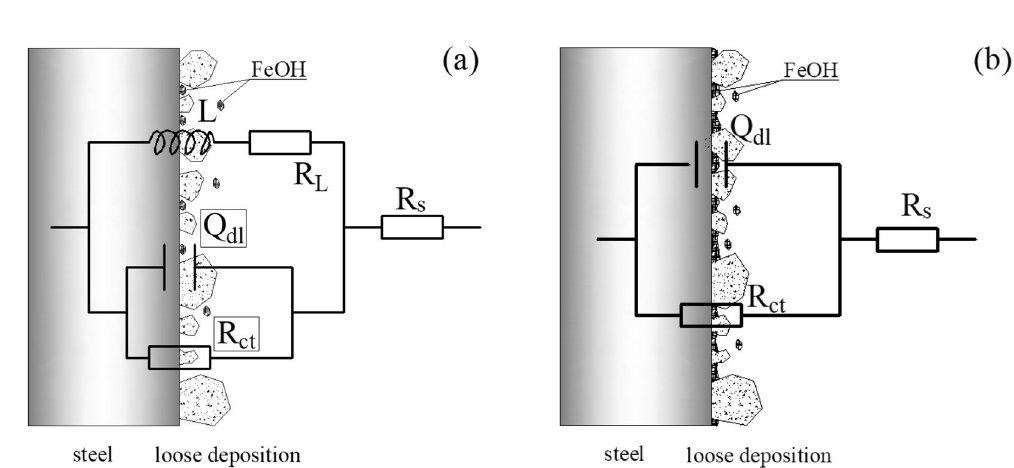
Figure 7. EIS spectra for sample with ADP under static liquid film, h = 8 mm: ( a ) Nyquist plots, ( b ) Bode and |Z| plots.